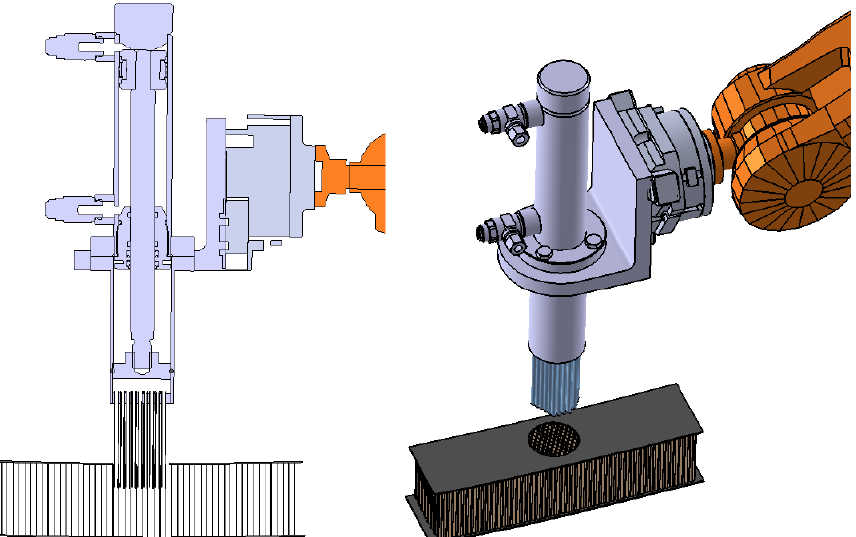
Figure 7. Design of the multi cell injection end-effector prototype. One single chamber for the resin, actuated by a piston, is filled with the mixed epoxy resin. The injector nozzle is made by a number of pipes fastened together in a circle. The pipe pattern must match that of the honeycomb below the skin at the potting